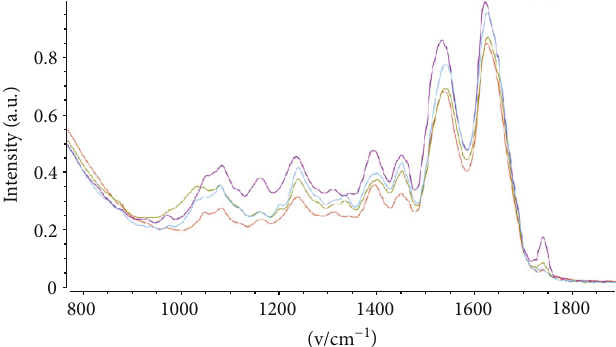
Figure 6: Comparison of low-frequency FT-IR spectra of di ff erent fresh salmon